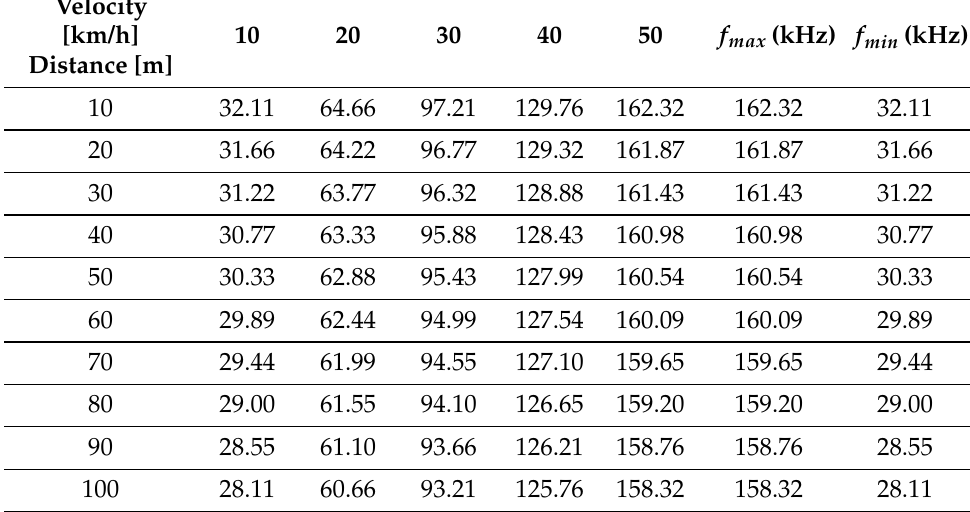
Table 1. Beat frequency calculation of FMCW radar (only UP